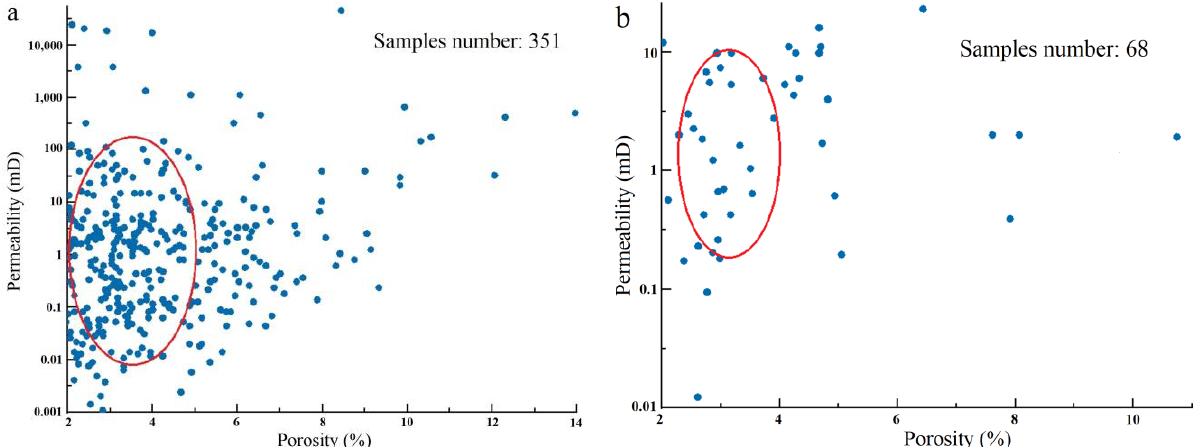
Figure 7. Relationship between permeability and porosity: ( a ) standard sample with size of ϕ25.4 mm × 50.8 mm; ( b ) full diameter core with a size of 120 mm. The red ellipses indicate the most concentrated data of the samples.